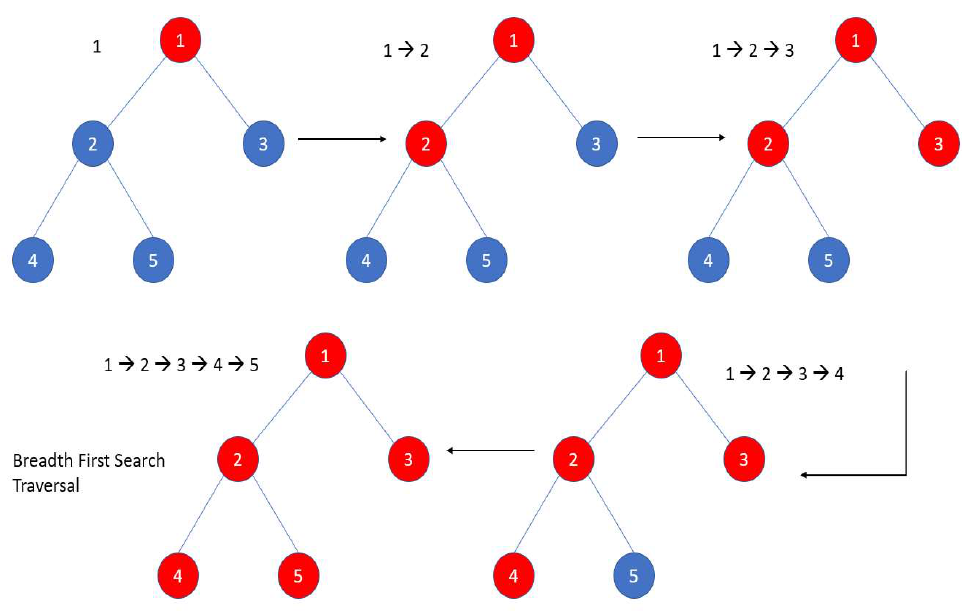
Figure 5. Breadth first search traversal.